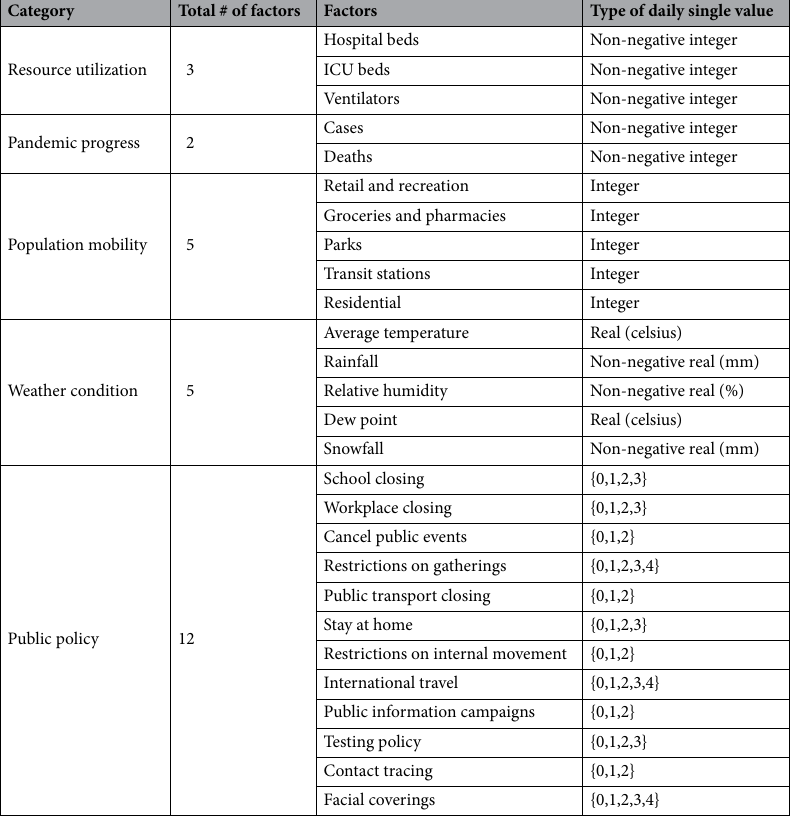
Factors used for forecasting